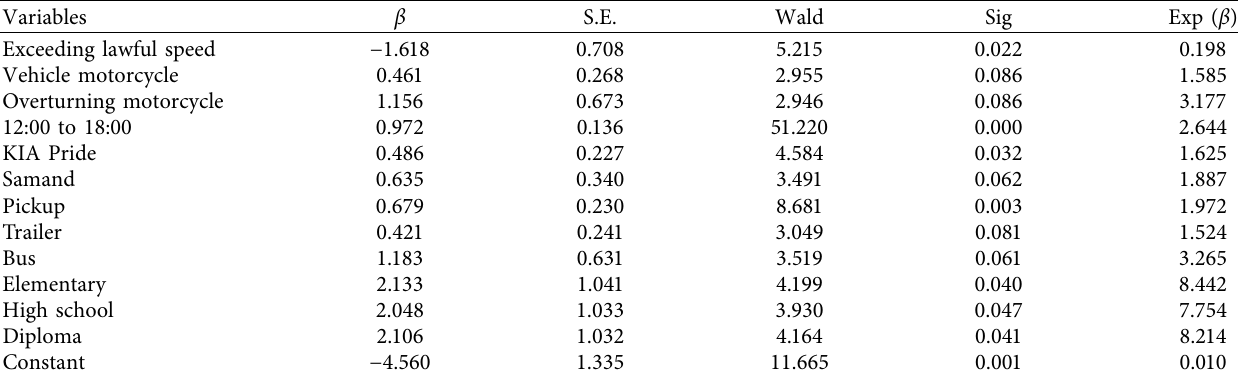
Table 11: The results of logit analysis in the first step.